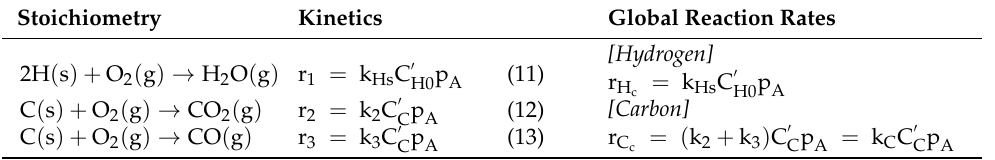
Table 2. Stoichiometry and overall reaction rates for solid carbon and hydrogen oxidation.